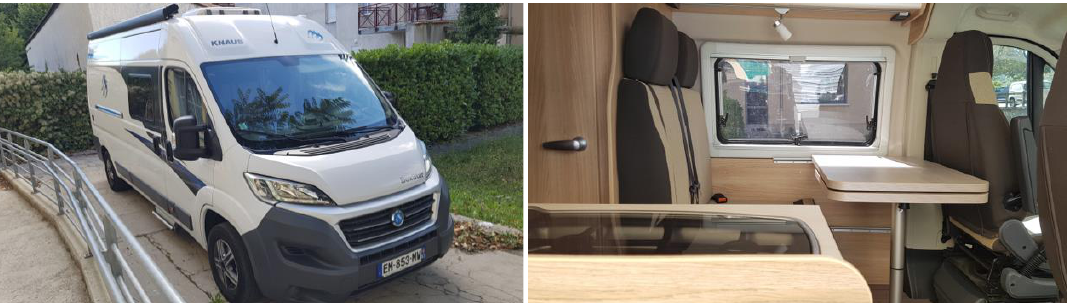
Figure 2. Exterior and Interior view of the camper van.